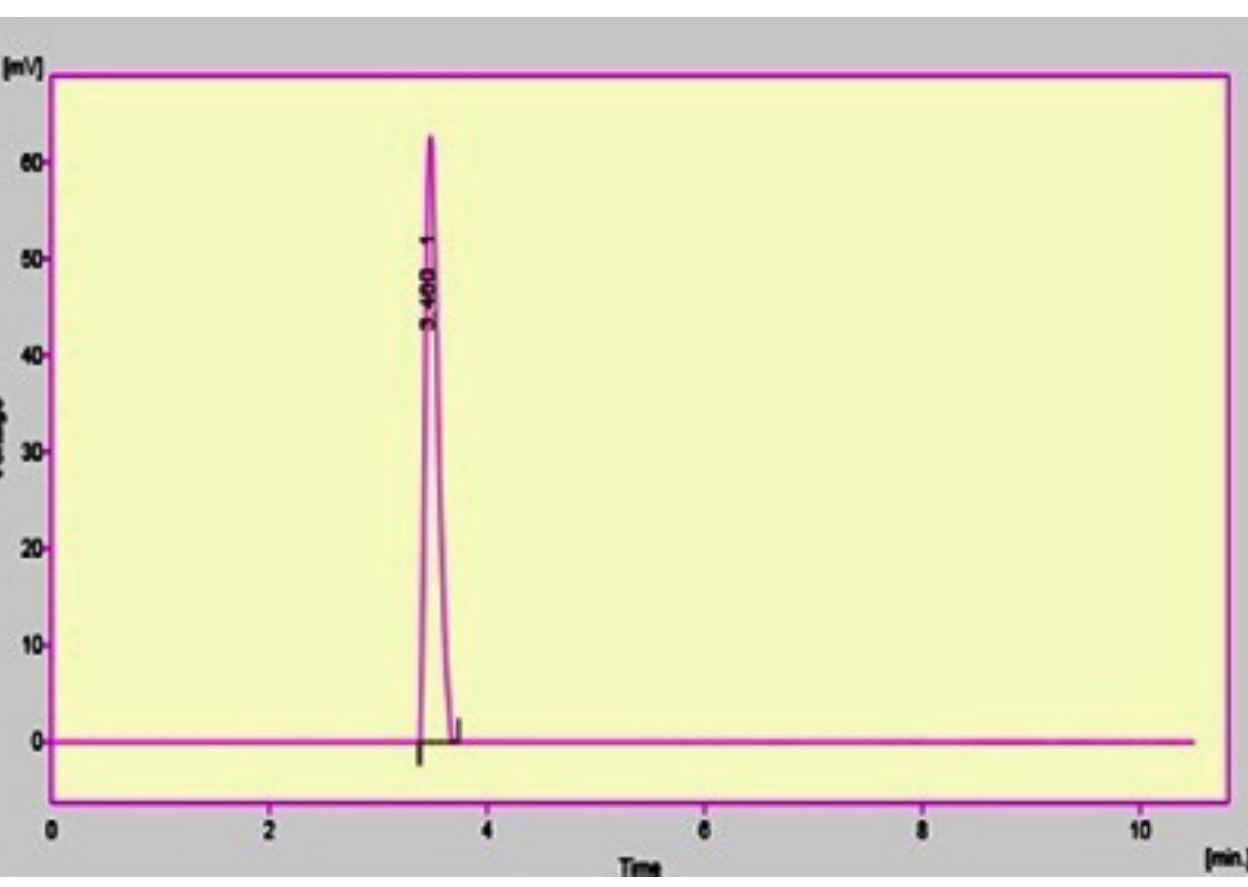
FIGURE 3 - Representative chromatogram of